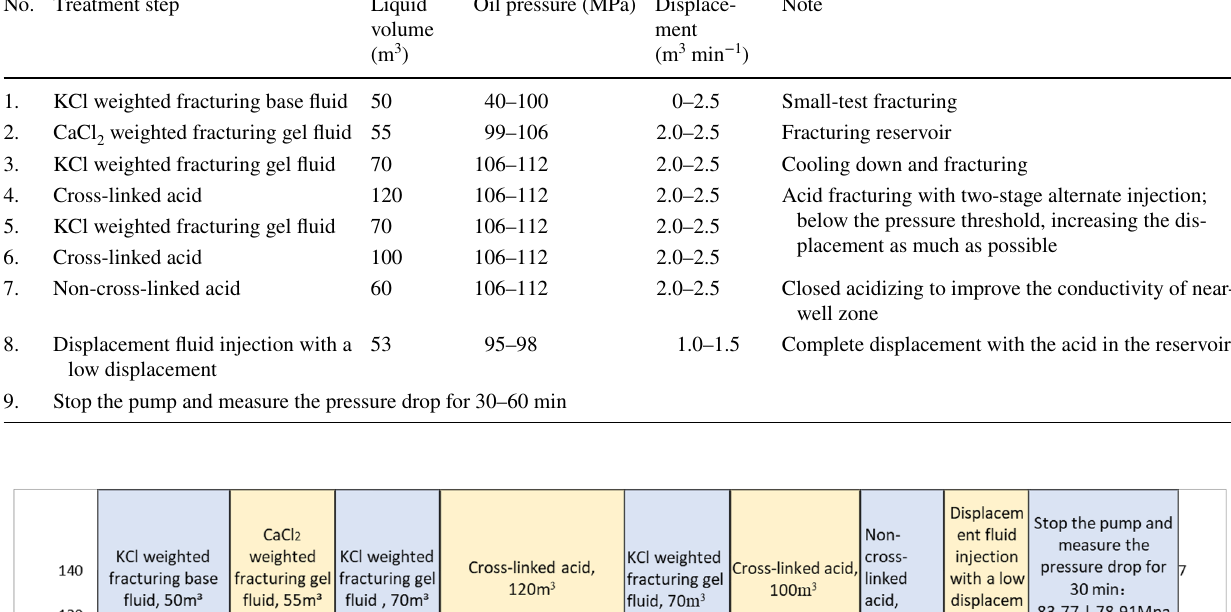
Table 4 Acid fracturing injection procedure of well Z2 No. Treatment step